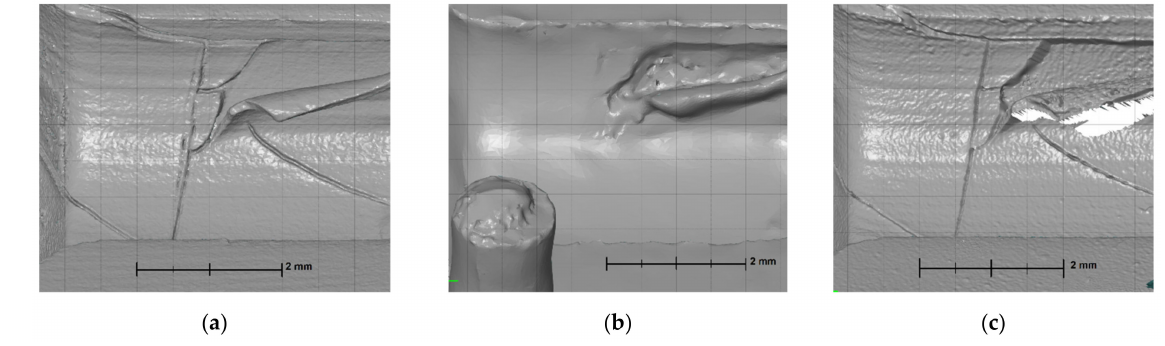
Figure 16. Flaking zone as measured with: ( a ) XCT; ( b ) BLS; ( c )